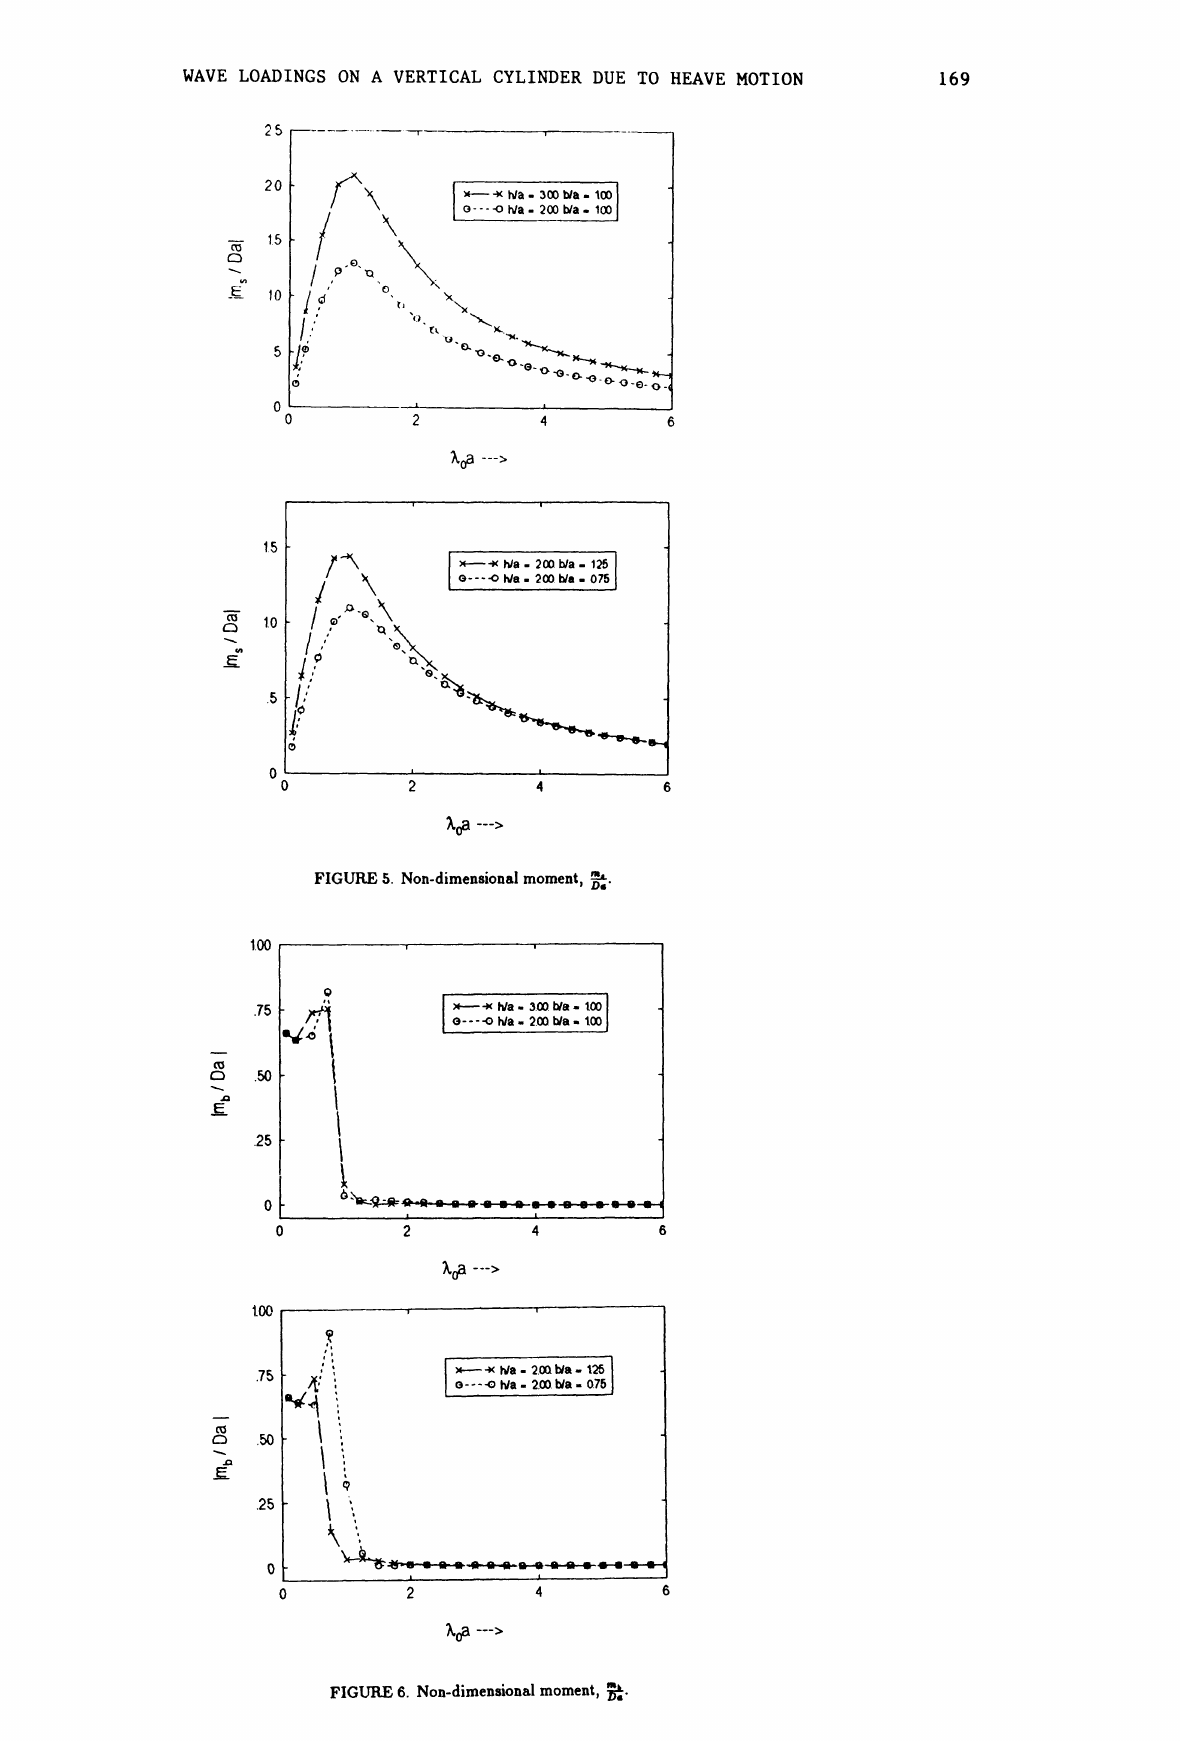
FIGURE 6. Non-dimensional moment,